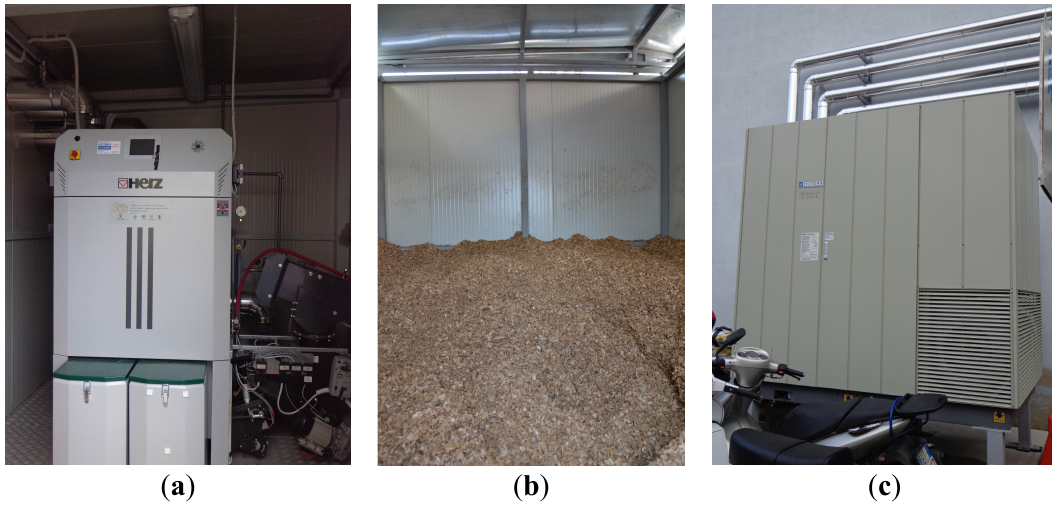
Figure 5. Chip-wood/pellet boiler with Li-Br absorption machine system: ( a ) the biomass boiler; ( b ) chip-wood storage; and the ( c ) Li-Br absorption